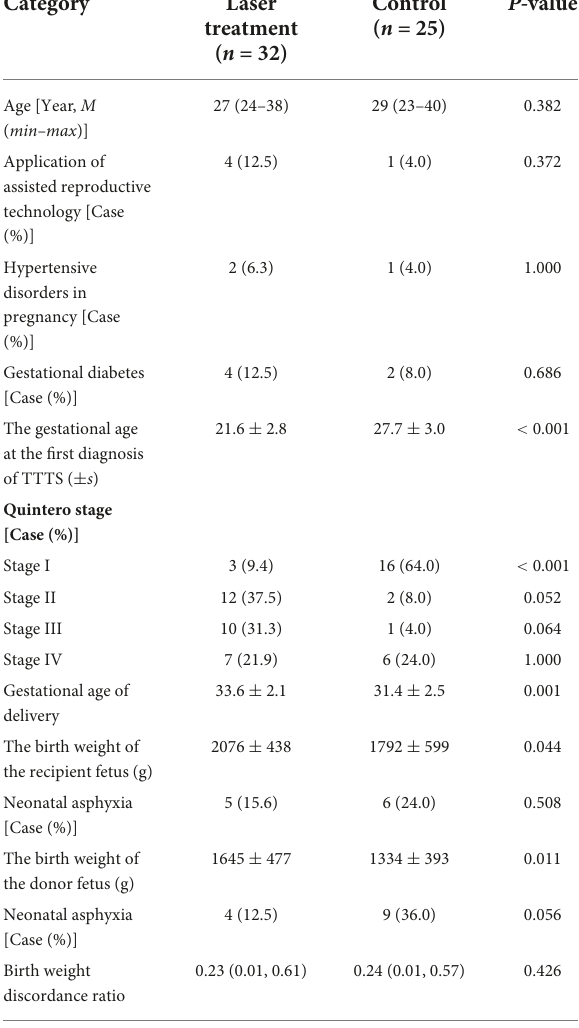
TABLE 1 The clinical features of TTTS patients between the two study groups.